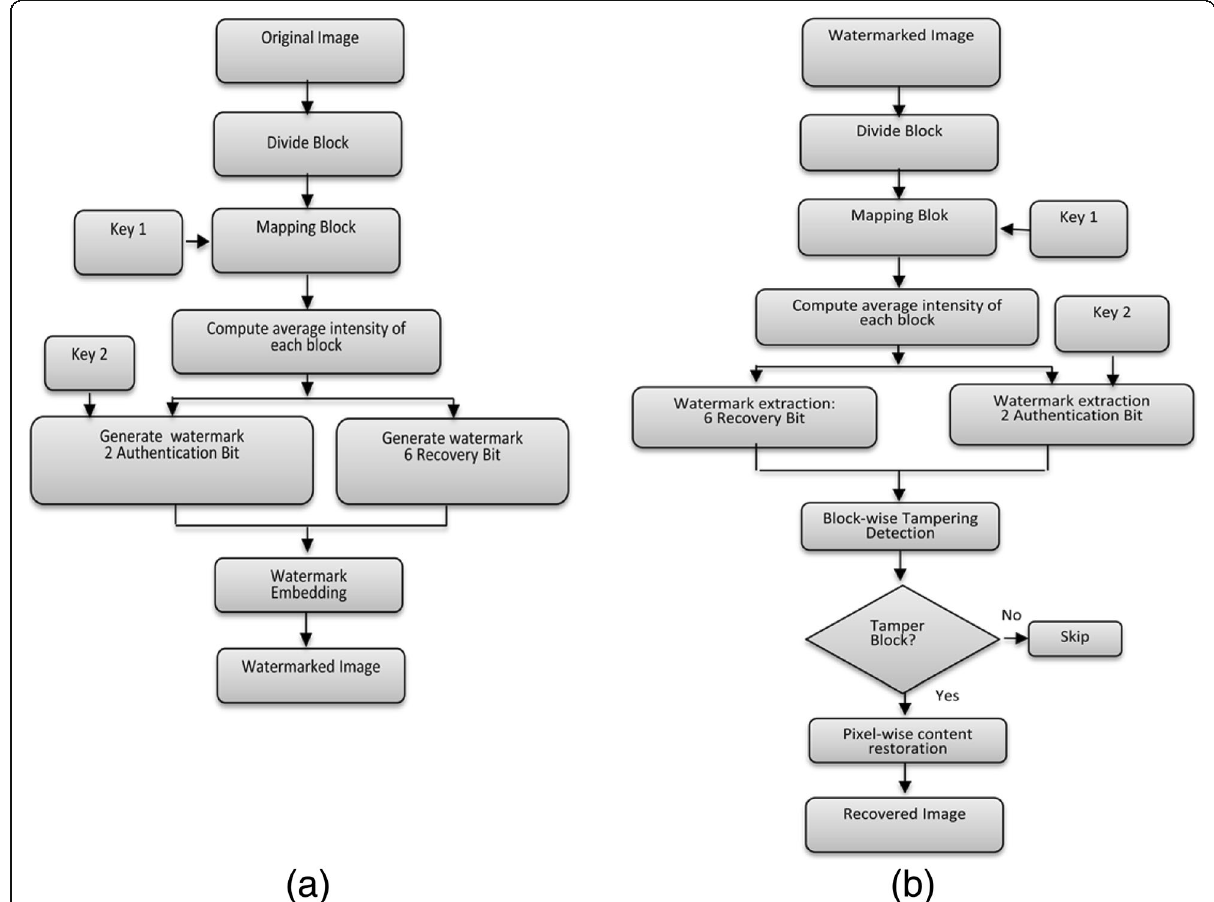
Fig. 13 Block diagram of ( a ) watermark embedding and ( b ) extraction process for Wang et al. ’ s method